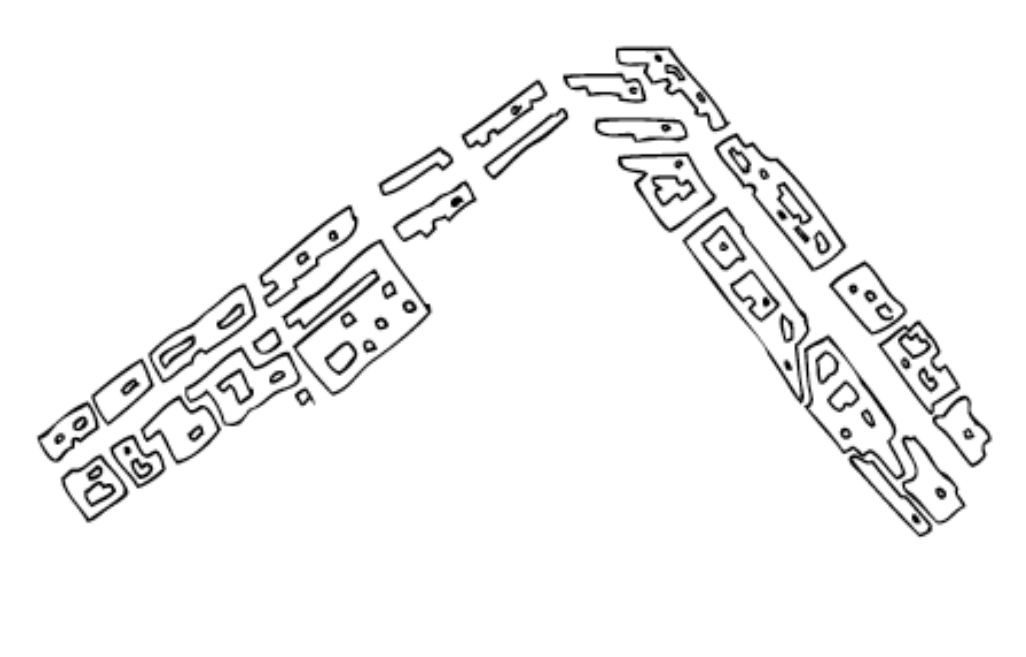
Figure 2. “Now I was on the other side of the